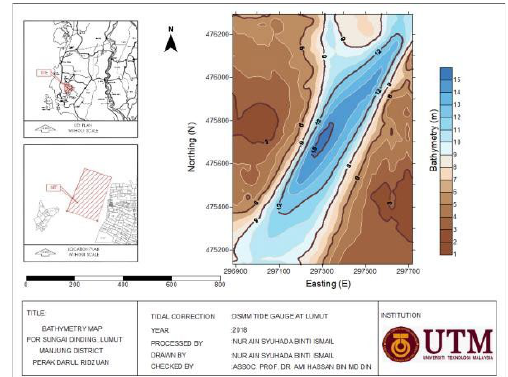
Figure 16. Bathymetric plan relative to the DSMM tide gauge